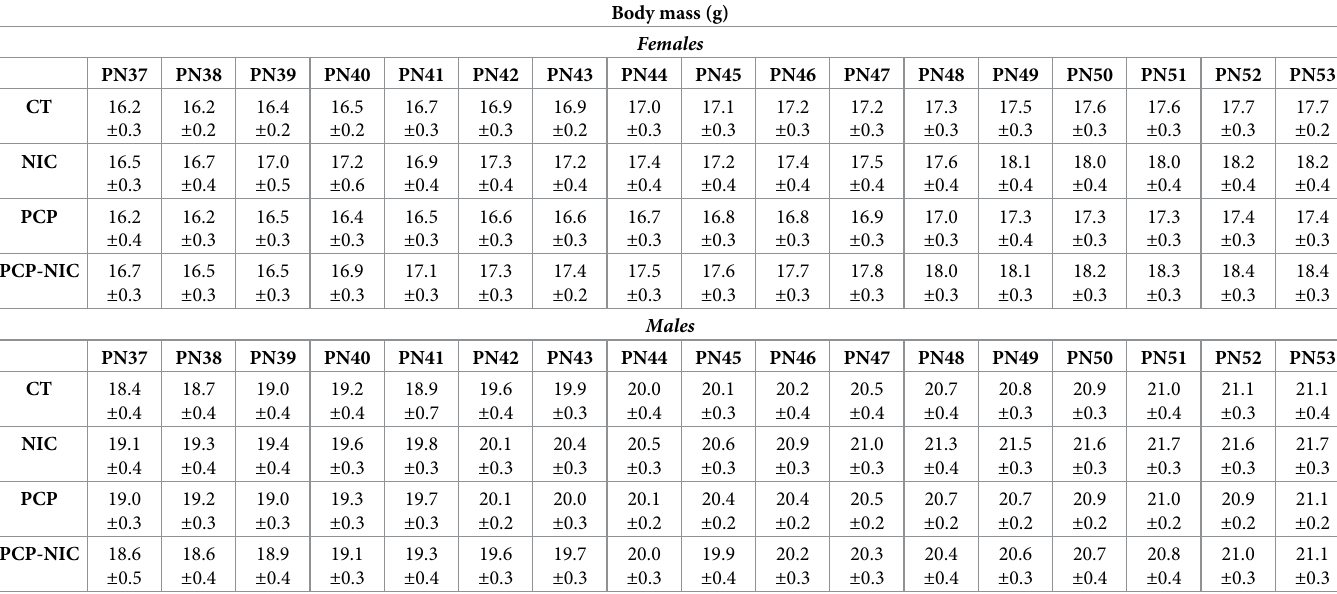
Table 1. Body mass gain throughout the experimental